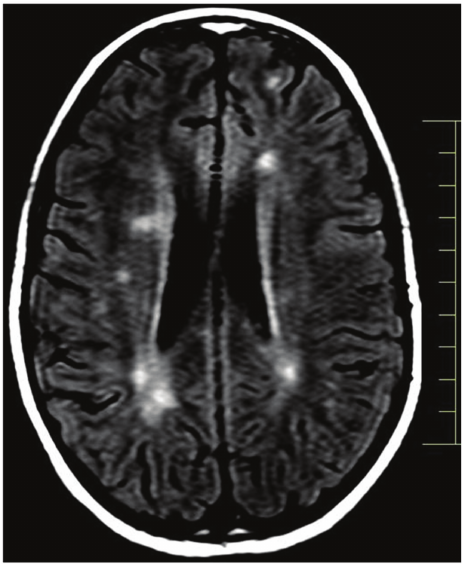
Figure 1: Brain MRI showing multiple periventricular lesions.